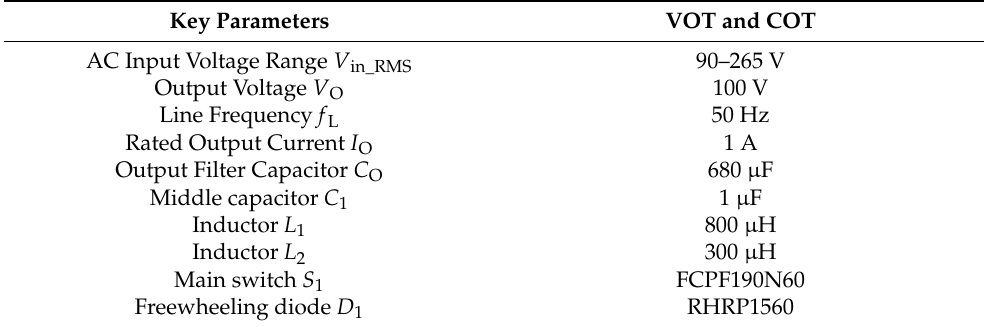
Figure 13. Simulation model of SEPIC PFC converter operating in BCM with VOT control. Table 1. Key Circuit